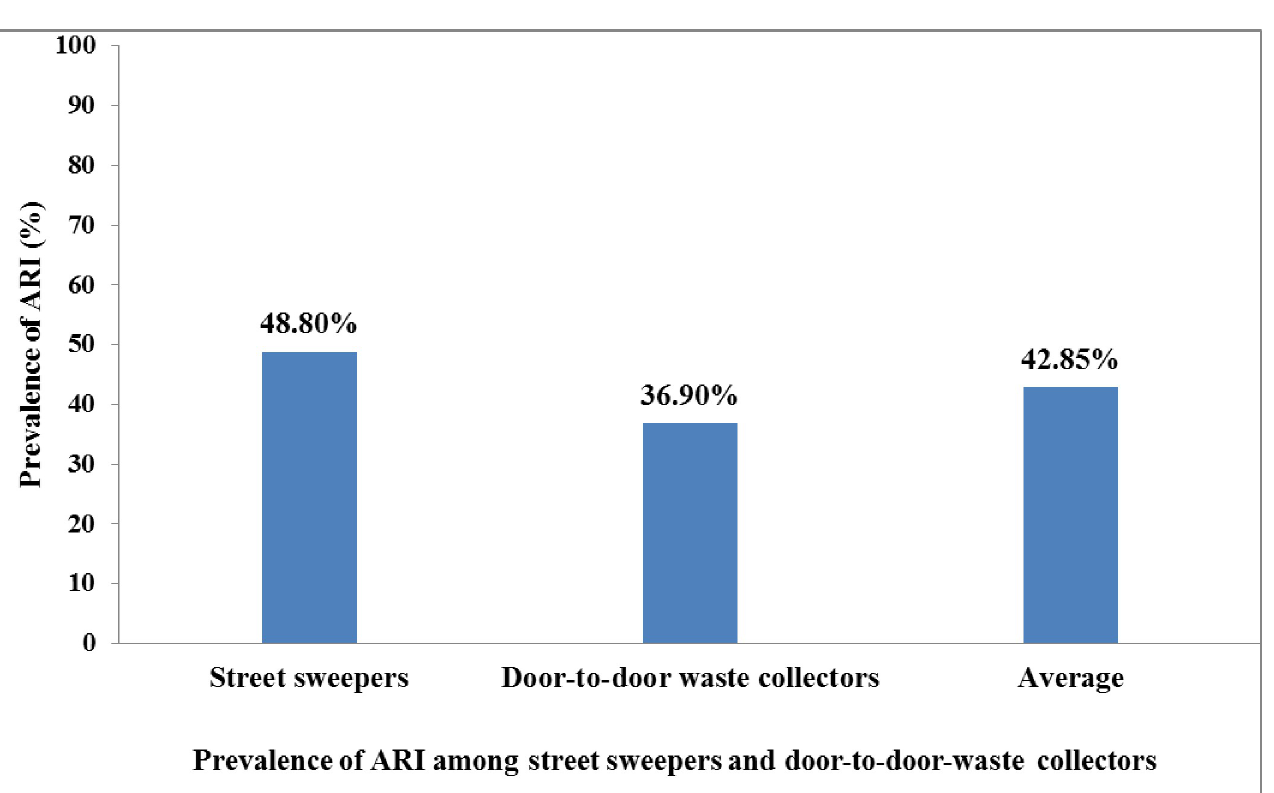
Fig 5. Prevalence of acute respiratory infection among street sweepers and door-to-door waste collectors in Dessie City, Ethiopia, March to May 2018.